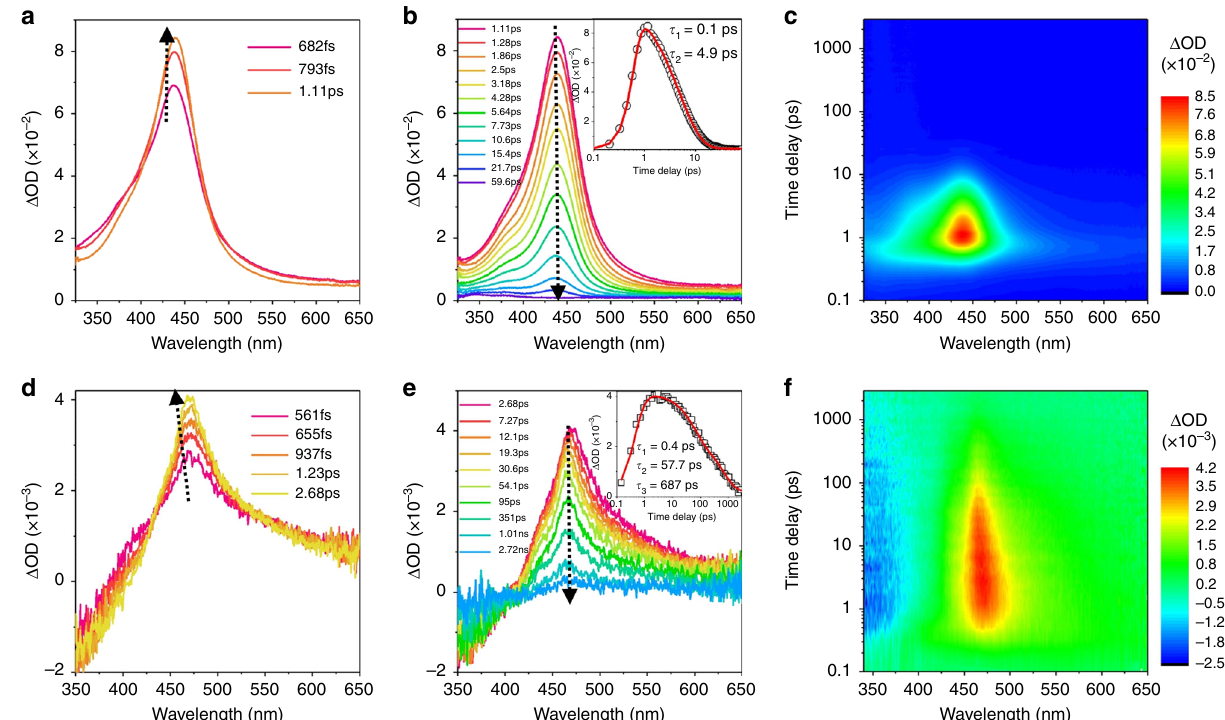
Fig. 6 Excited-state dynamics by ultrafast time-resolved spectroscopy. a , b Femtosecond transient-absorption (fs-TA) spectra of COTh in MeCN at different time delays acquired after femtosecond laser excitation at 267 nm. Inset: kinetic traces at 440 nm (black circle) are inserted in b . d , e fs-TA spectra of COTh fi lm at different time delays acquired after femtosecond laser excitation at 267 nm. Inset: kinetic traces at 470 nm (black circle) are inserted in e . c and f Contour plots of the time-resolved absorption spectroscopic responses are shown. Δ OD ¼ log I 100 through the sample before excited states are created, I T is the transmitted light through the COTh 52,53 . The femtosecond transient-absorption (fs-TA) spec- tra of COTh obtained after 267 nm excitation in acetonitrile with a time delay up to 59 ps are shown in Fig. 6a − c. As presented in